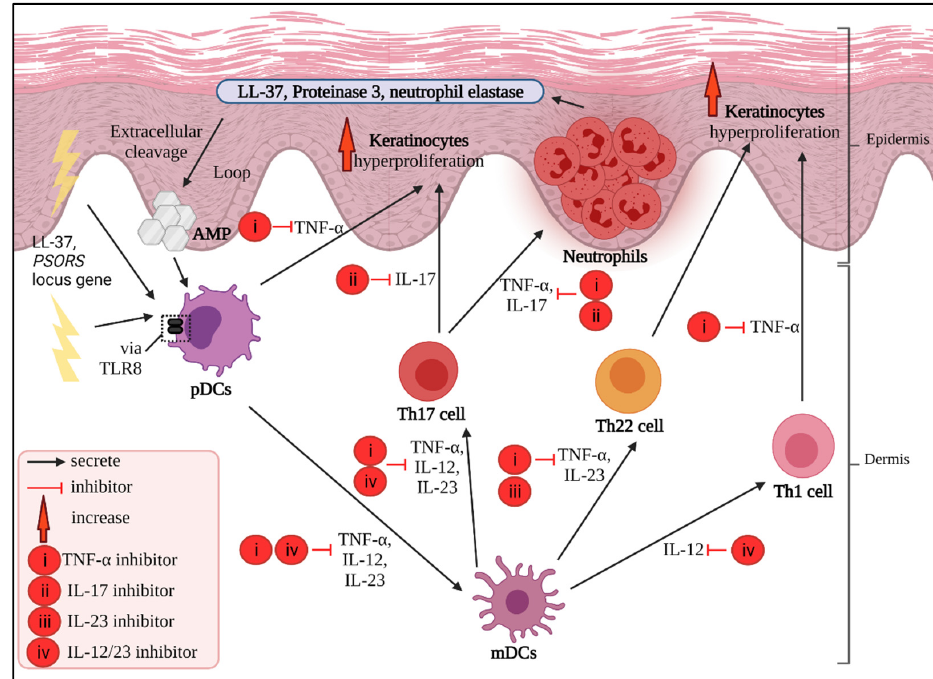
Figure 3. Cytokine inhibitors and their respective blocking interests based on the postulated psoriasis pathogenesis. The overexpressed cytokines released by respective cells can be blocked, and this can downregulate the further inflammatory pathway.